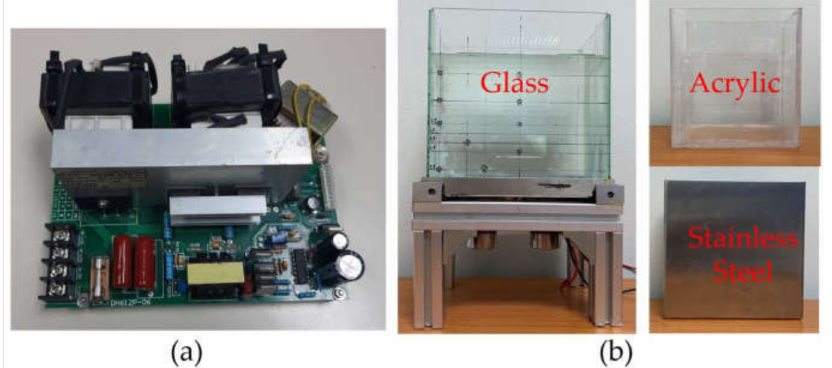
Figure 5. The equipment for experiment: ( a ) a modified circuit board and ( b ) a built UCT.